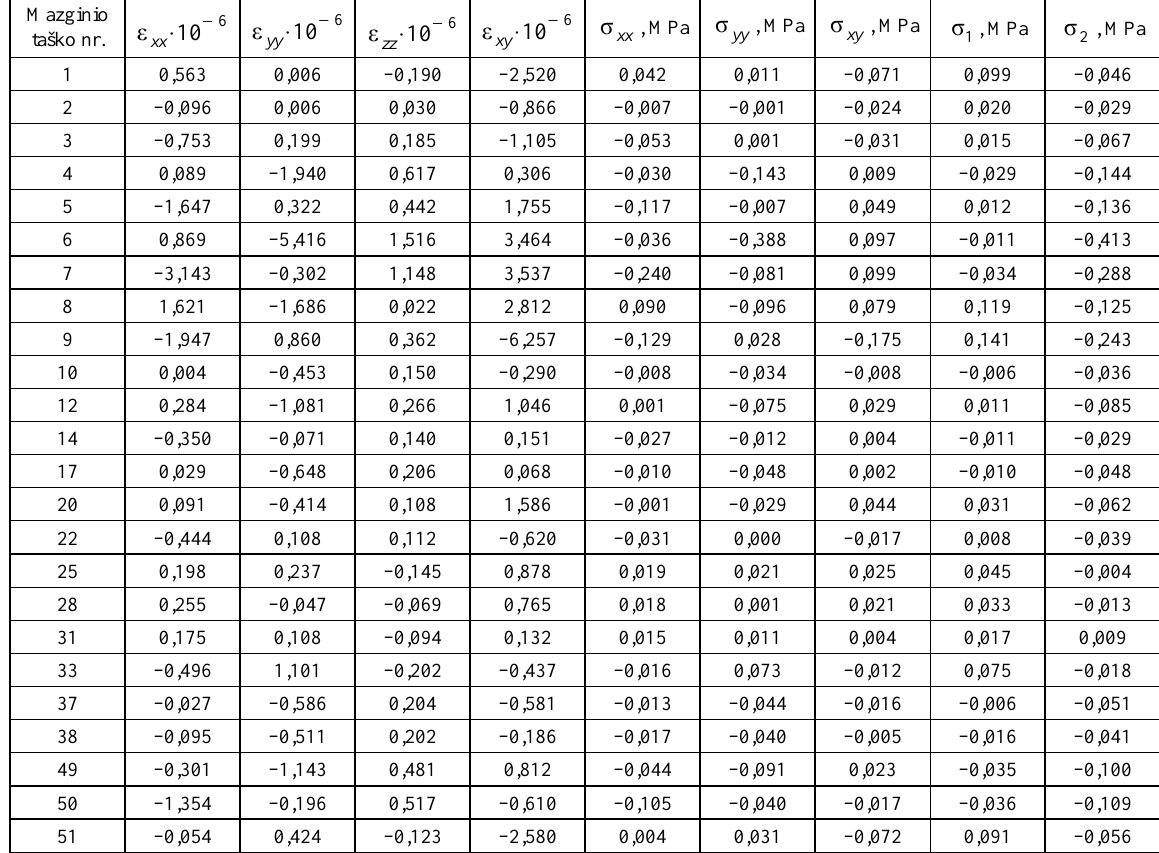
3 lentel ė . Horizontaliosios deformacijos bei tektonini ų į tamp ų prieaugiai Table 3. Horizontal deformations and growths of tectonic stresses Mazginio taško